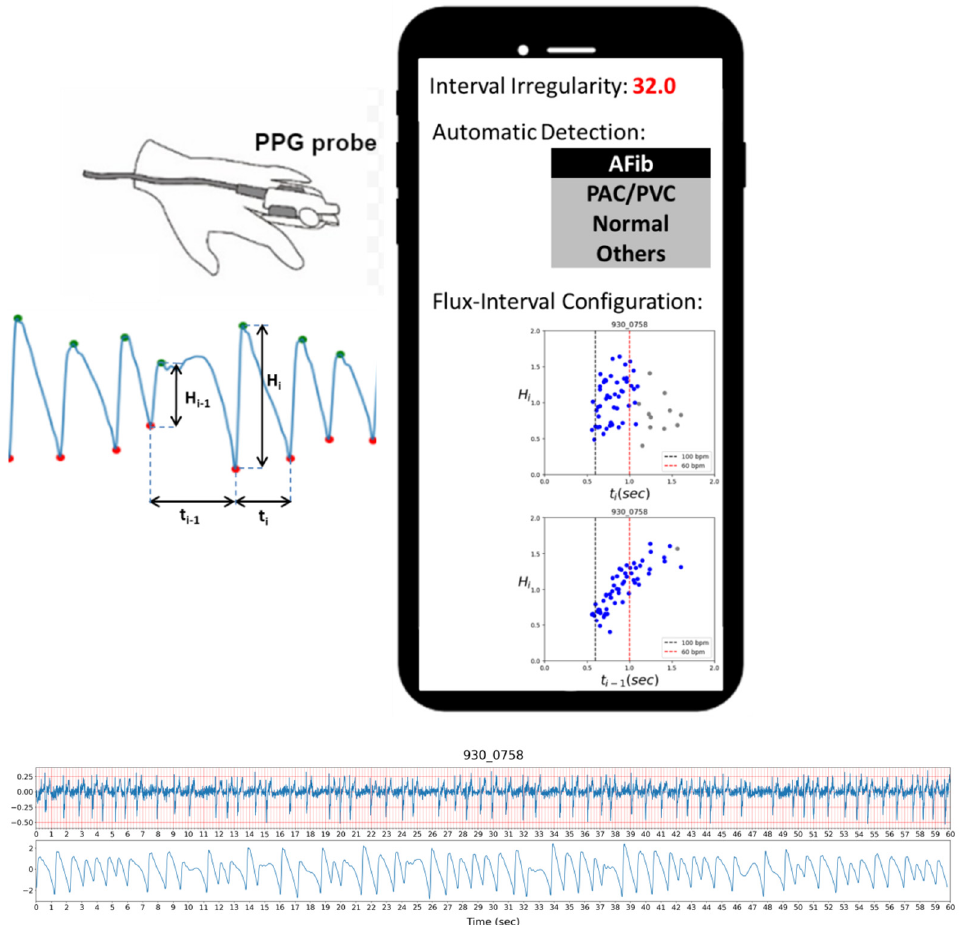
Figure 1. Demonstration of automatic AFib detection and visual assessment displayed on a smartphone with a PPG probe.